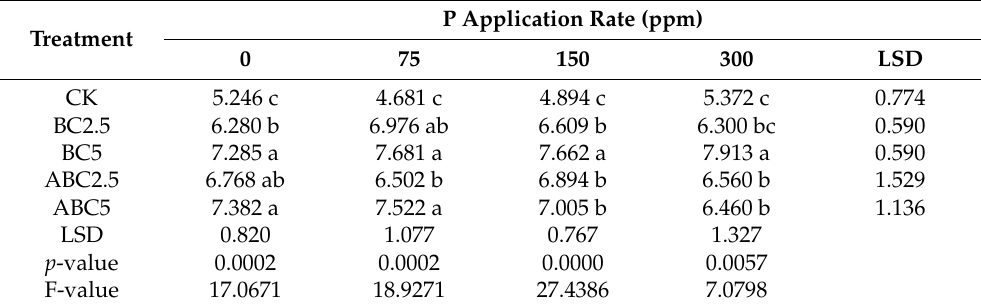
Table 6. Effects of BC and ABC applied at different rates with different P fertilizer application rates on soil CEC in meq/100 g soil.